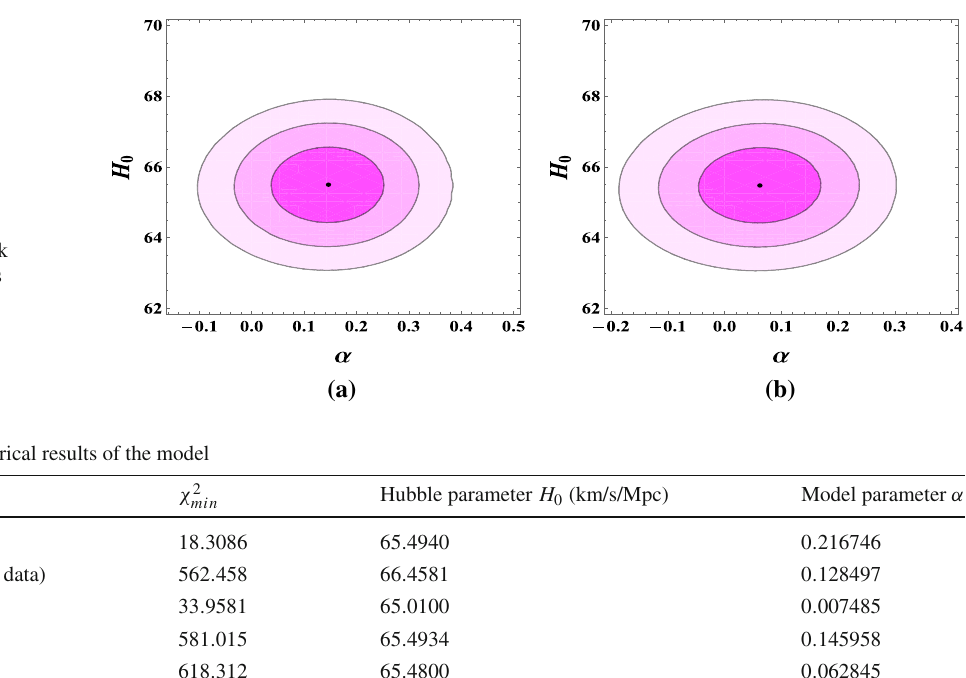
Table 1). Also the good fit value of the model parameter α